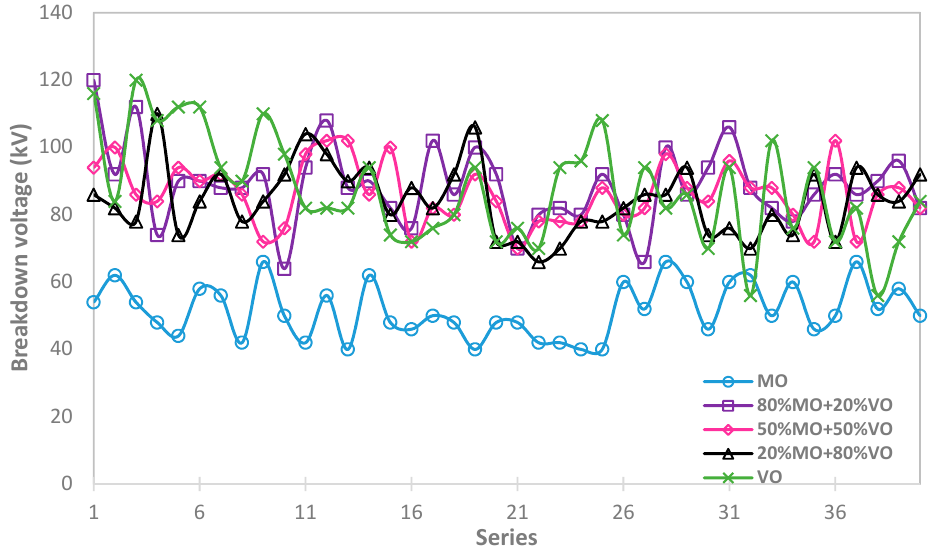
Figure 10. Distribution of breakdown voltages under AC of mineral (MO)/vegetable oil (VO) mixtures.